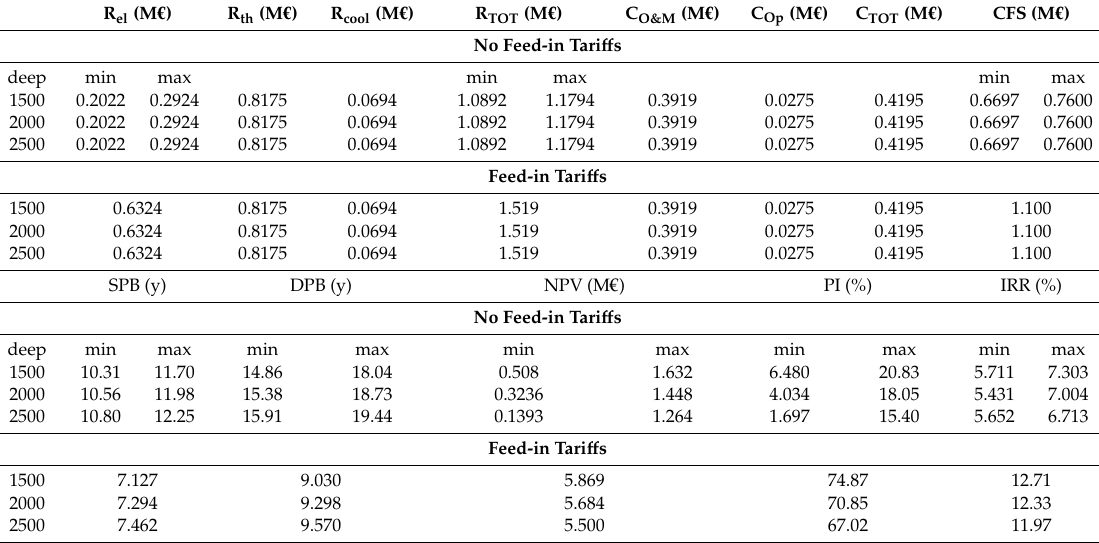
Table A7. Main results of the economic analysis (on a yearly basis; stop time of the DHCN at